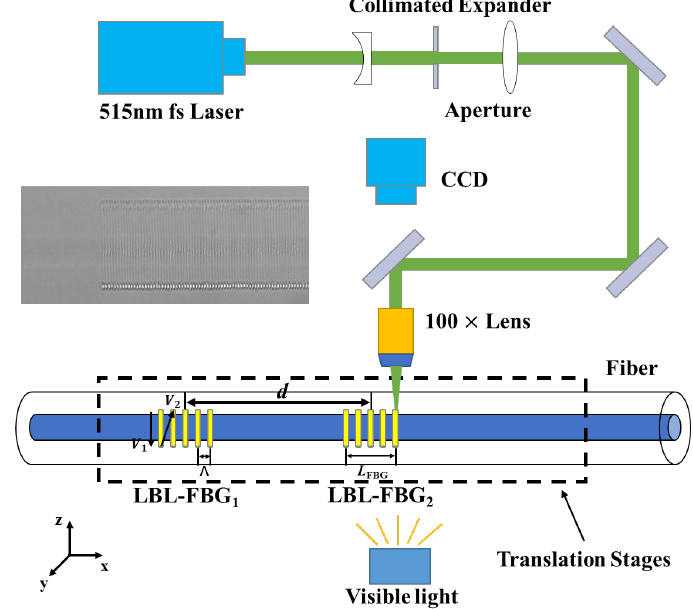
Figure 5. Schematic of the fs laser line-by-line scanning writing system. Inset: microscopic image (100×) of single FBG.